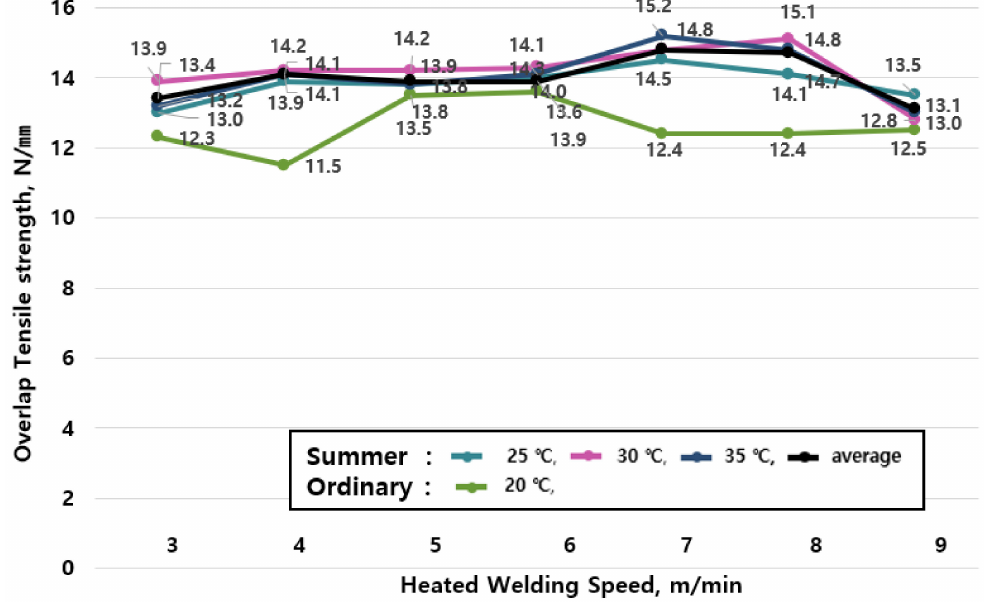
Figure 7. Tensile strength test results by joint construction temperature (summer